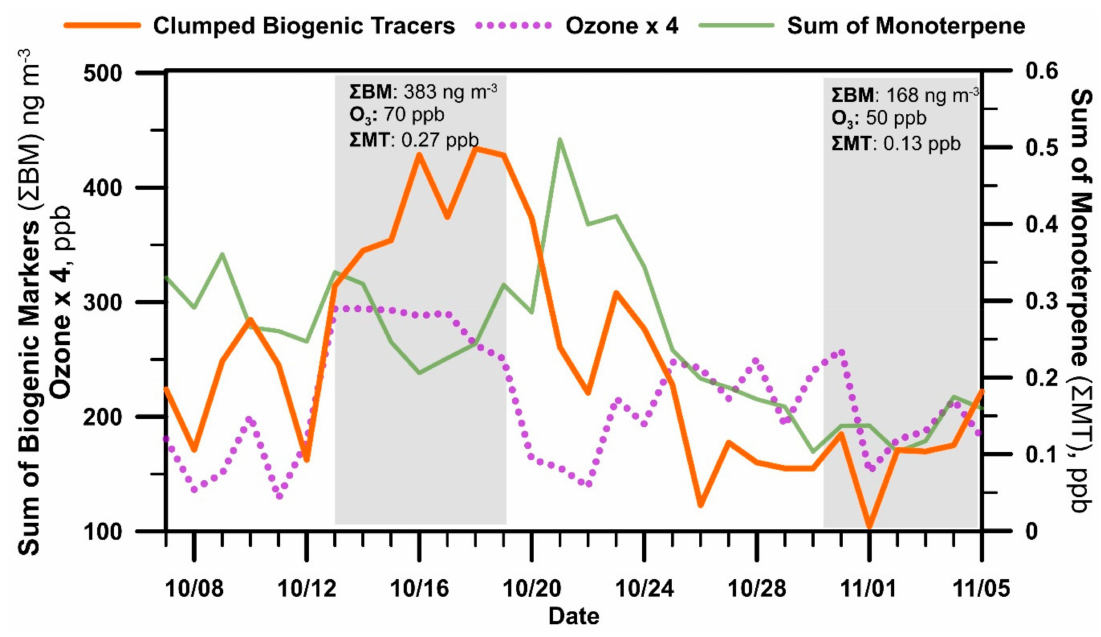
Figure 4. Time series profile of the mass concentration of clumped biogenic tracers including pinonic, pinic, norpinonic acid, and pinonaldehyde. Moreover, included in the figure are the time series of ozone and sum of monoterpene mixing